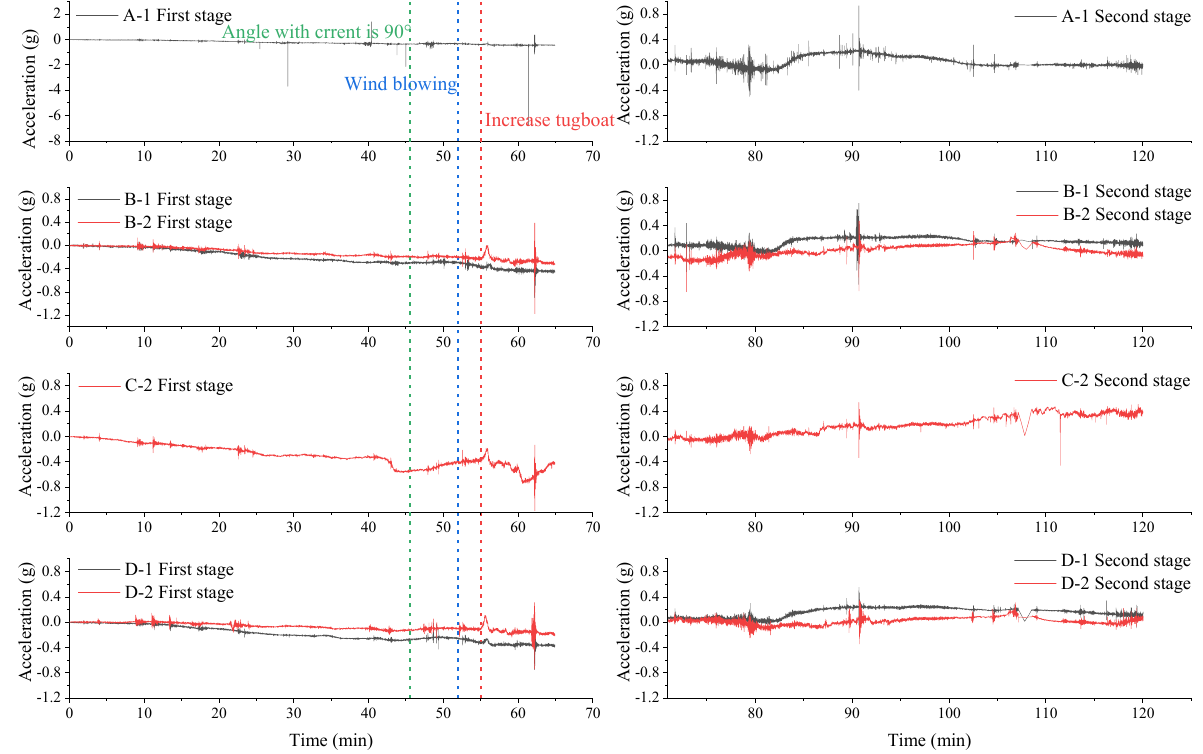
Figure 12. Data diagram of floating vibration of pipeline segment 2.